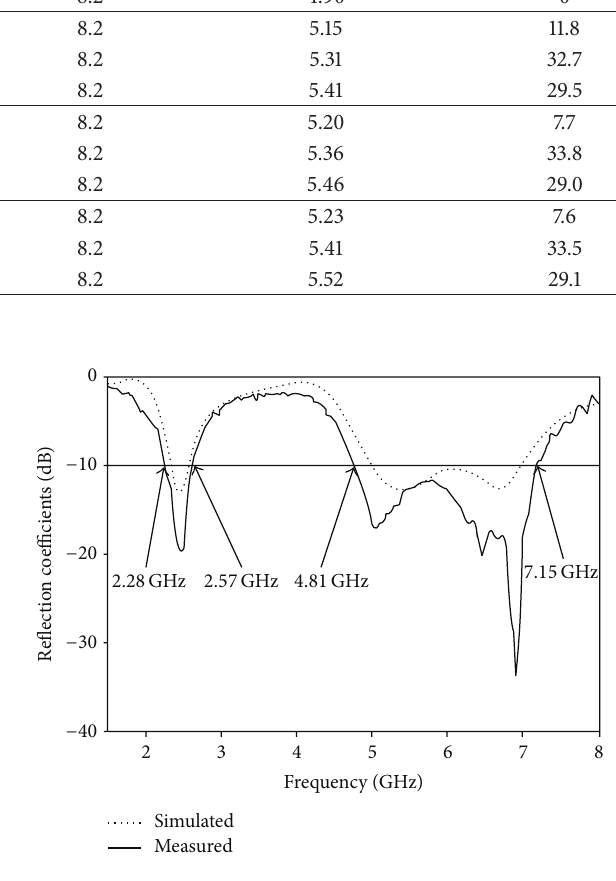
Figure 6: Simulated and measured reflection coefficients of the pro- posed antenna.